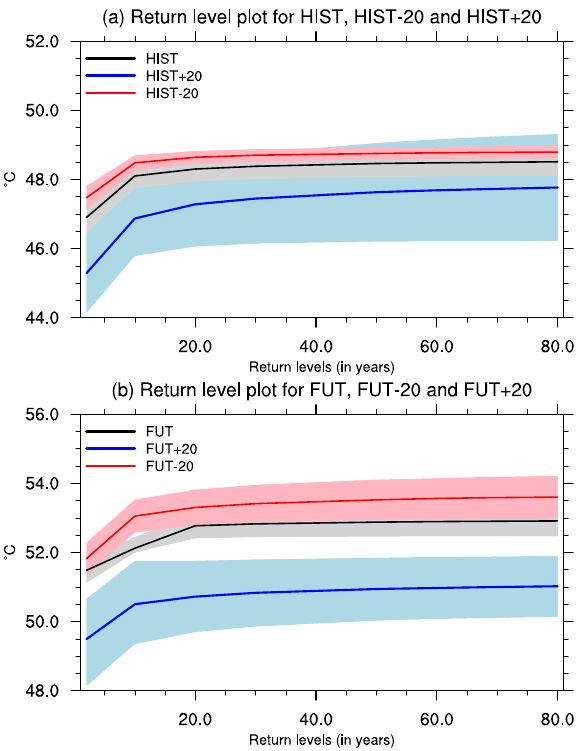
Fig. 8 Generalized extreme value (GEV) distribution. Return level plot of ExTI for control run (black line), dry SM perturbation experiments (red line) and wet SM perturbation experiments (blue line) over the NCI estimated using the non-stationary GEV model fi t for ( a ) historical period (1951 – 2010) and ( b ) future projection (2051 – 2100). The area between the upper and lower con fi dence interval of return levels for control, dry SM and wet SM experiments are fi lled with light grey, light red and light pink colours,